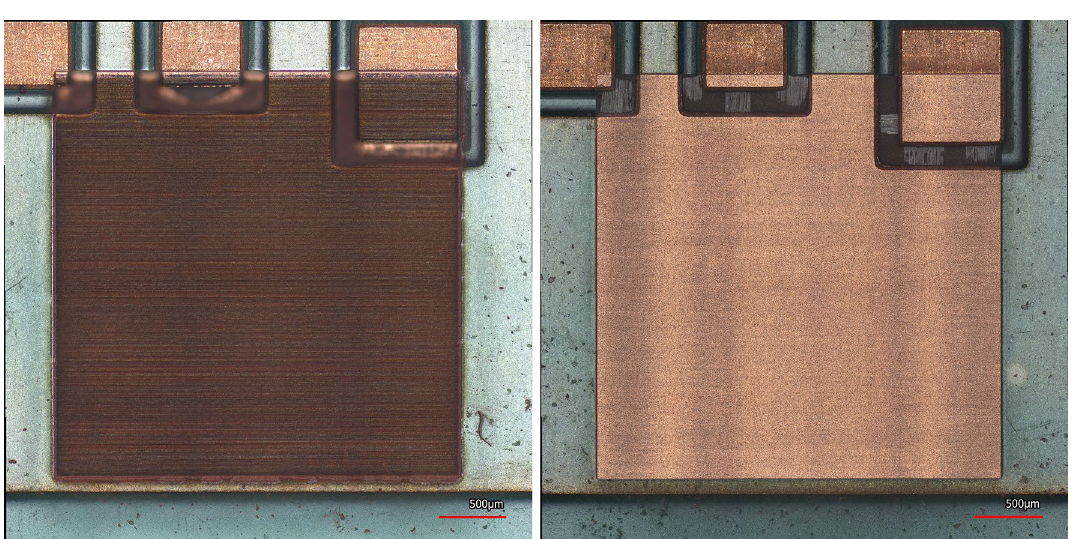
Figure 9. The tradeoff between throughput and cleanliness is shown. Left: use of high power to create a trench. Right: use of low power and a higher number of cycles to obtain a trench with the same